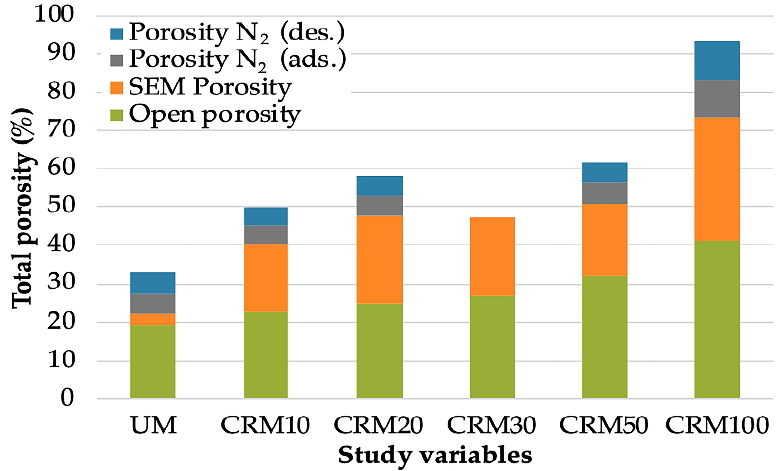
Figure 16. Percentages of total porosity obtained by the techniques used.